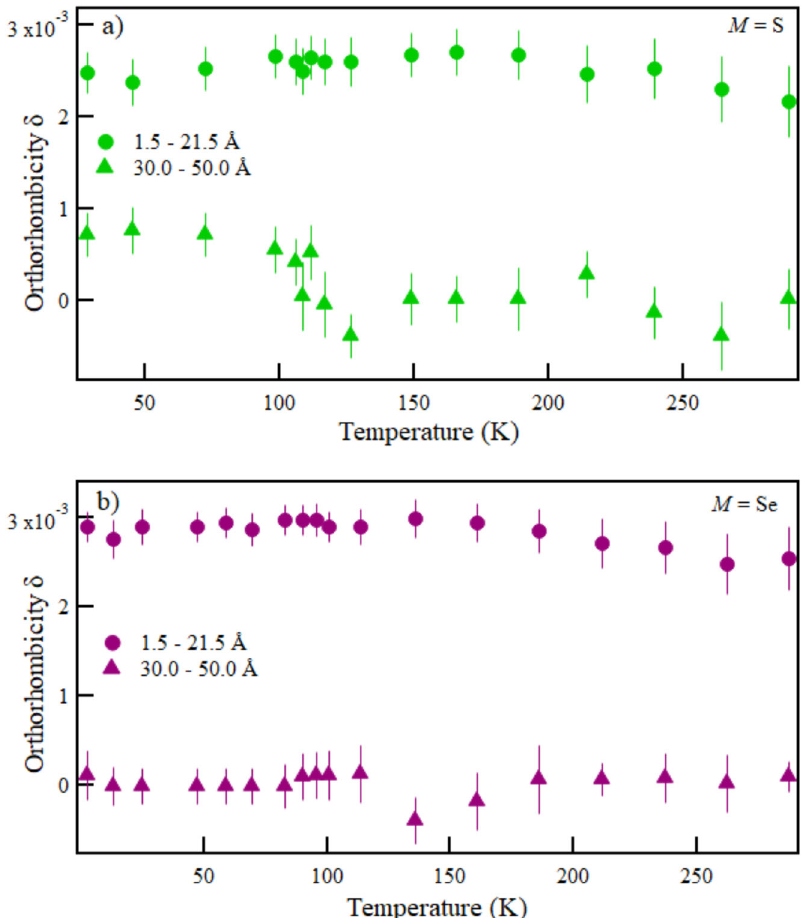
Fig. 3 The local orthorhombicity derived from the pair distribution function. Temperature dependence of orthorhombicity for short- fi tting range (1.5 – 21.5) Å and long- fi tting range (30.0 – 50.0) Å for a M = S and b M = Se. In both of these fi gure orthorhombicity is along y -axis and temperature is in x -axis. A solid circle symbol indicates the short- fi tting range (1.5 – 21.5) Å and a solid triangle symbol indicates the long- fi tting